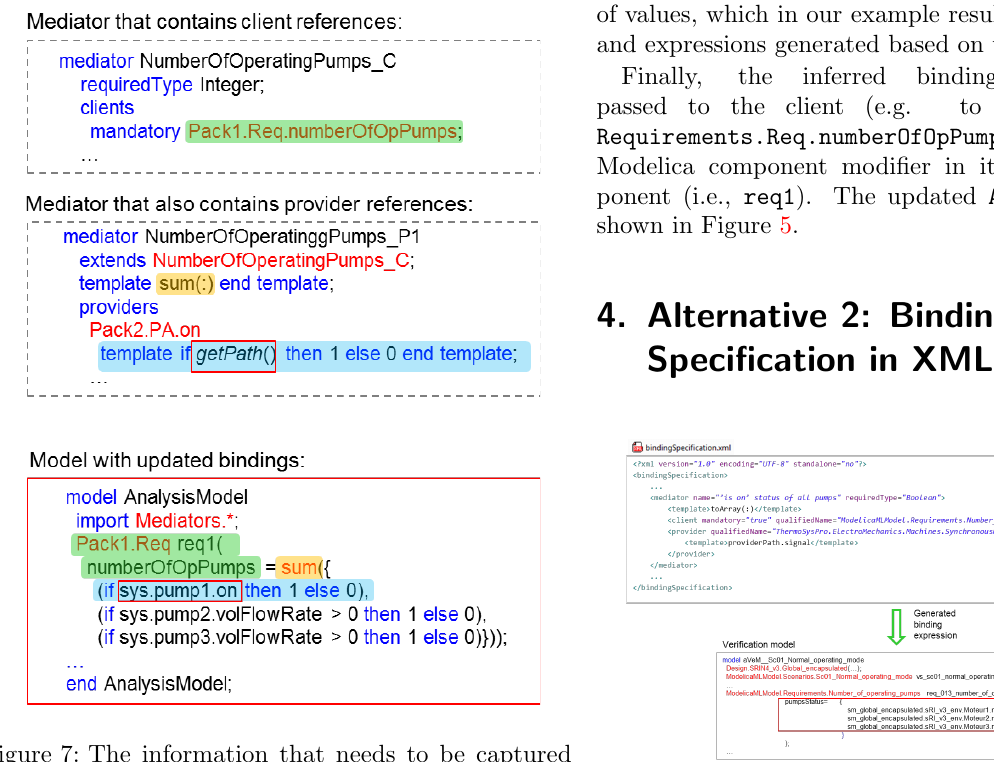
Figure 7: The information that needs to be captured in abstract syntax.